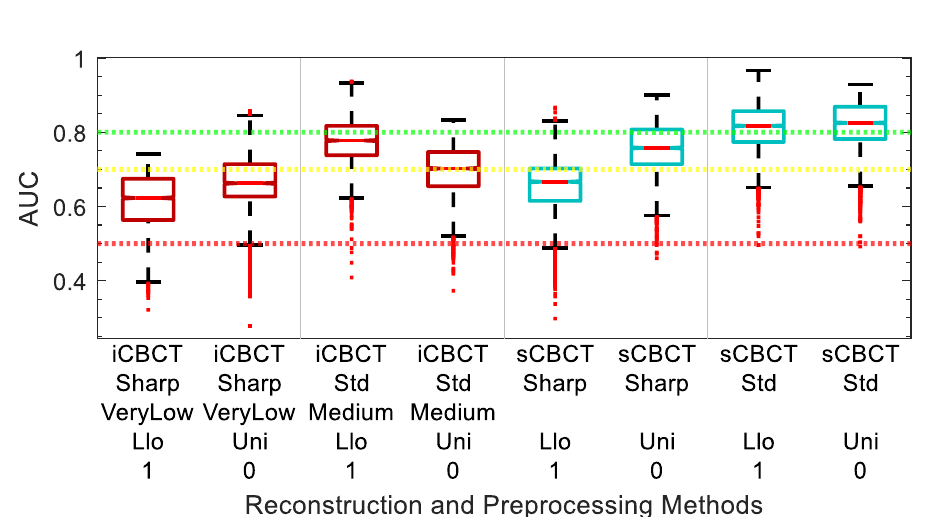
Figure 7. Sub-Acute GU Toxicity AUC of delta-radiomic models vs Reconstruction and Preprocessing methods. The AUC collected over 1000 iterations of the leave-one analysis and over all BED